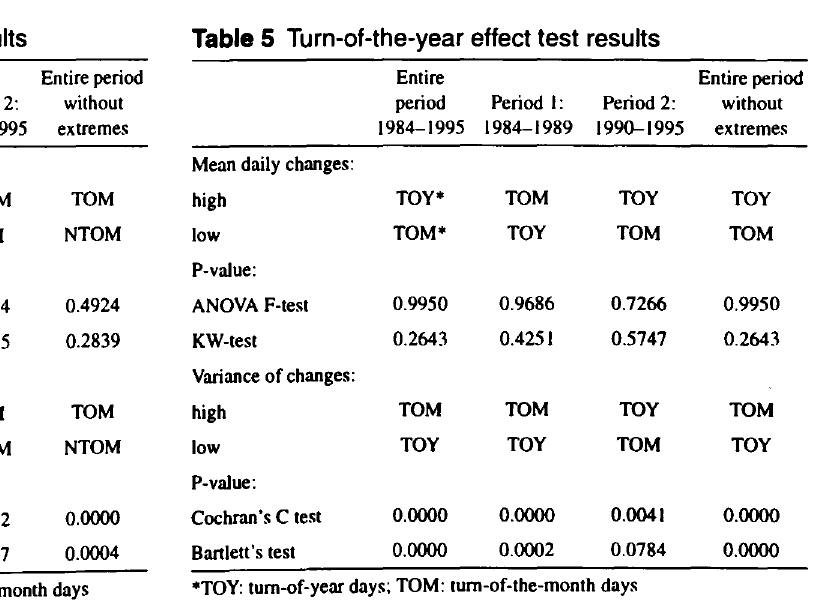
Table 4 Turn-of-the-month effect test results Table 5 Turn-of-the-year effect test